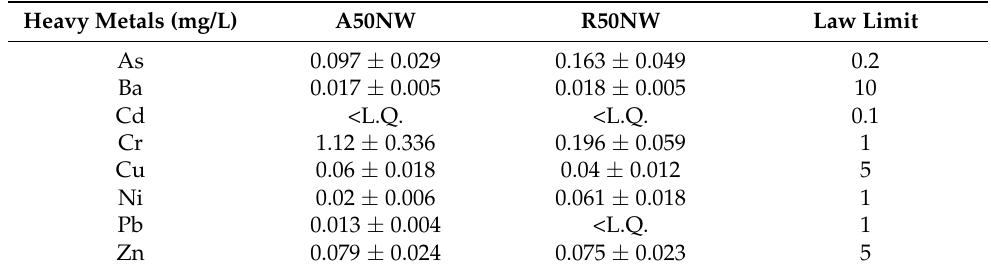
Table 5. Heavy metals (mg/L) in A50NW and R50NW AAMs eluates after leaching test (EN 12457-2).